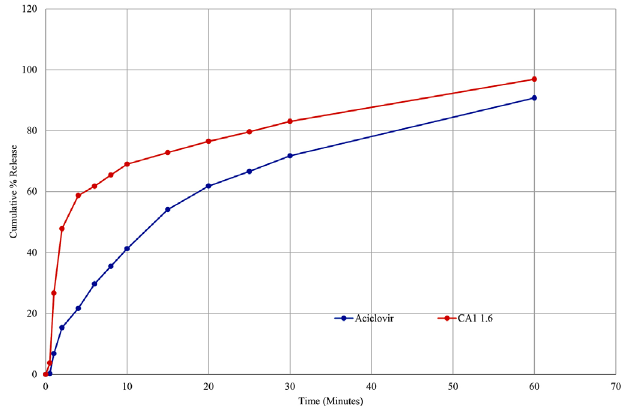
FIGURE 5 - Cumulative % release of CA1 in comparison with